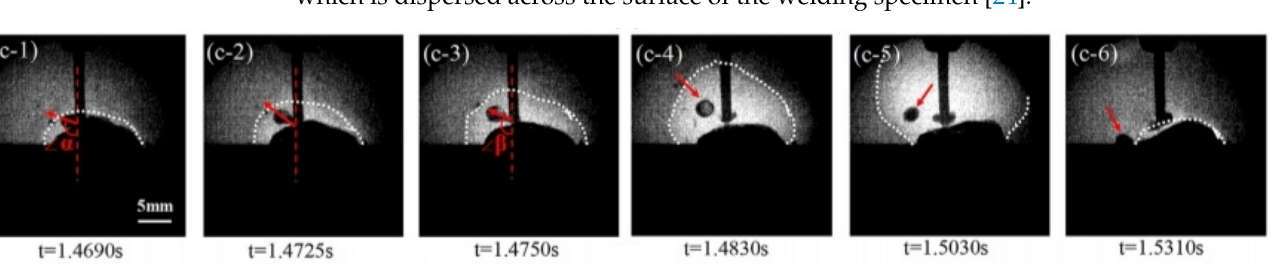
Figure 13. Droplet transfer into a spatter at different time intervals [25]. Reprinted with permission from Ref. [25]. 2022, Elsevier.